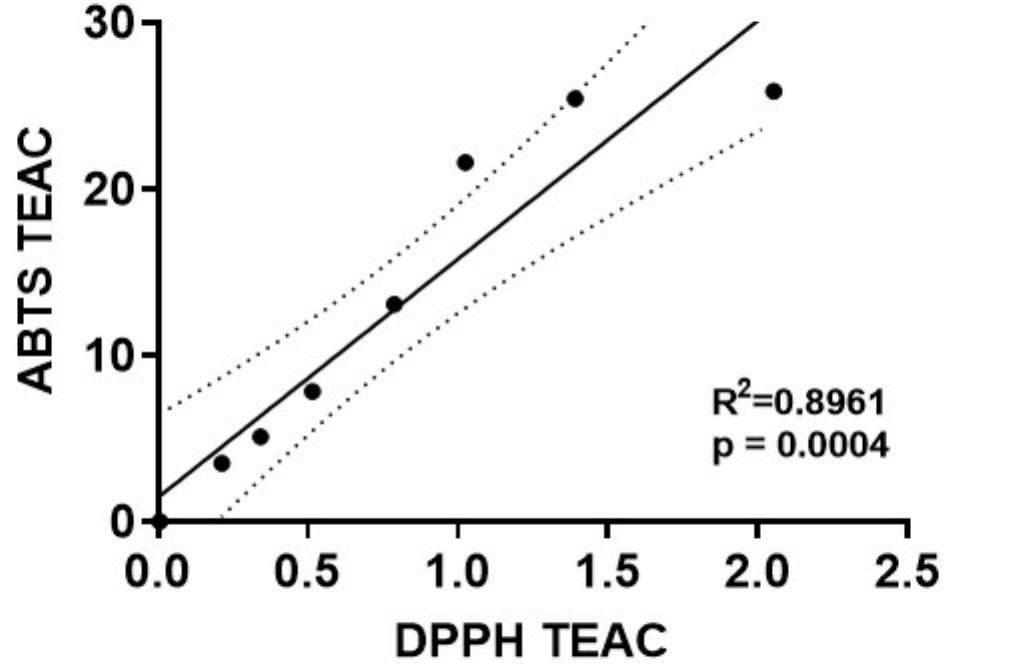
Figure 4. Correlation of mdivi-1’s dose-dependent antioxidant capacity values measured by two different radical depletion assays. The Trolox-equivalent antioxidant capacity (TEAC) of mdivi-1 in the ABTS • + (y-axis) and DPPH radical (x-axis) depletion assays was found to be significantly correlated by linear regression analysis (R 2 = 0.8961, p = 0.0004). Dotted line depicts 95% confidence bands for the best-fit line. Note that the axes have different scales.